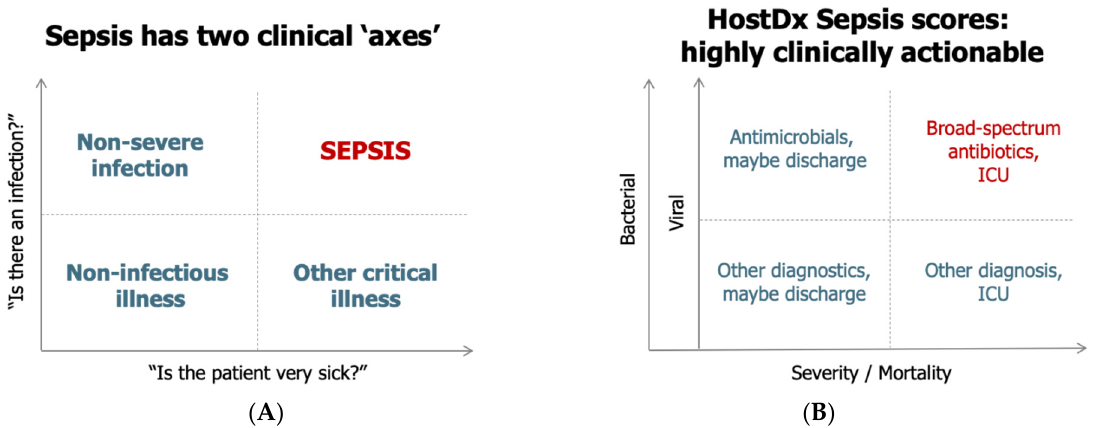
Figure 1. The two axes of sepsis: presence of infection and severity ( A ), and the broad and distinct clinical actions associated with the two axes ( B ). ICU: intensive care unit.